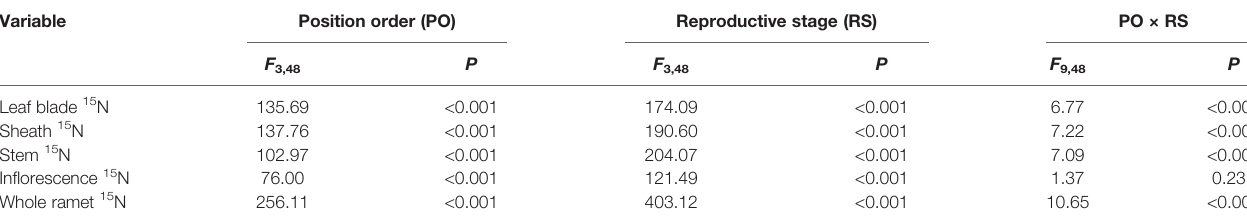
TABLE 4 | Two-way ANOVA for the effects of position order, reproductive stage and their interaction on amounts of 15 N (log-transformed) translocated from labeled vegetative ramets toward the leaf blade, sheath, stem, in fl orescence, and whole ramet of basipetal reproductive ramets.